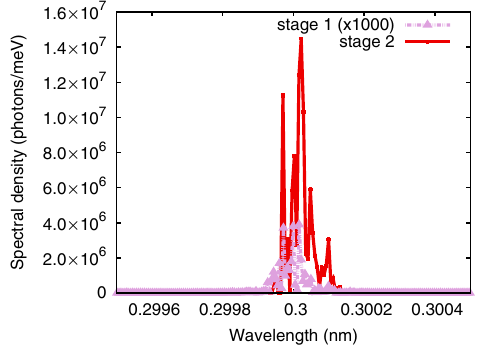
FIG. 6. Spectrum of 4 keV part of radiation for the reversed example at the end of stage 1 (scaled up by a factor of 1000) and at the end of stage 2. The undulator parameters of the two stages must be fine-tuned in order to center the spectra around the same point.